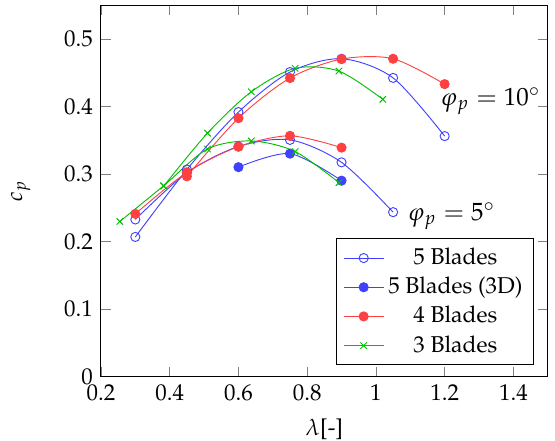
Figure 13. Three, four and five blades compared at different phase angles. Additionally, the simulation was carried out once again in the 3D configuration at ϕ p = 10 ◦ .